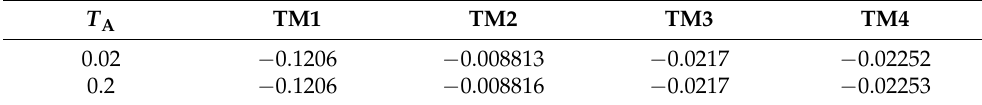
Table 5. Damping coefficient for TM1–TM4 of SG under different T A ( K A =